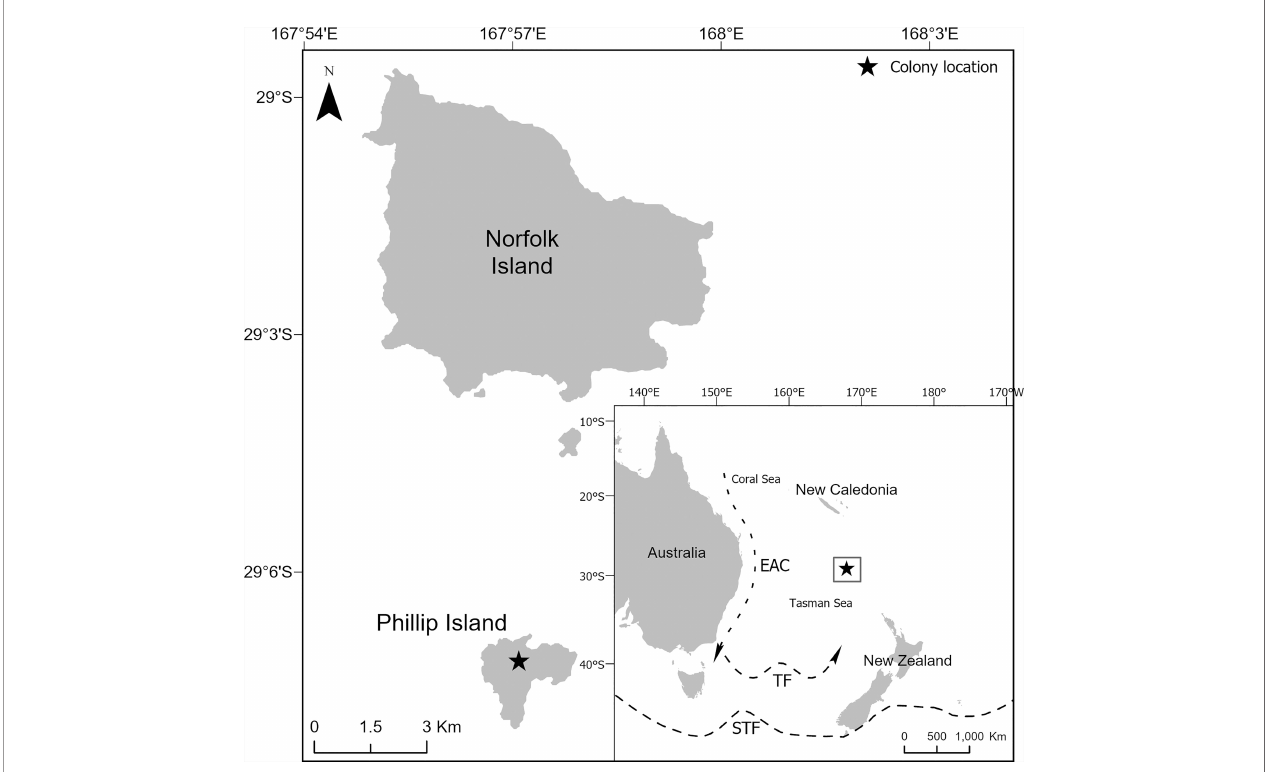
FIGURE 1 | The location of the Norfolk Island Group in relation to Australia, New Zealand and New Caledonia. Included are the approximate locations and direction of fl ow of the East Australian Current (EAC), the Tasman Front (TF) and the Subtropical Front